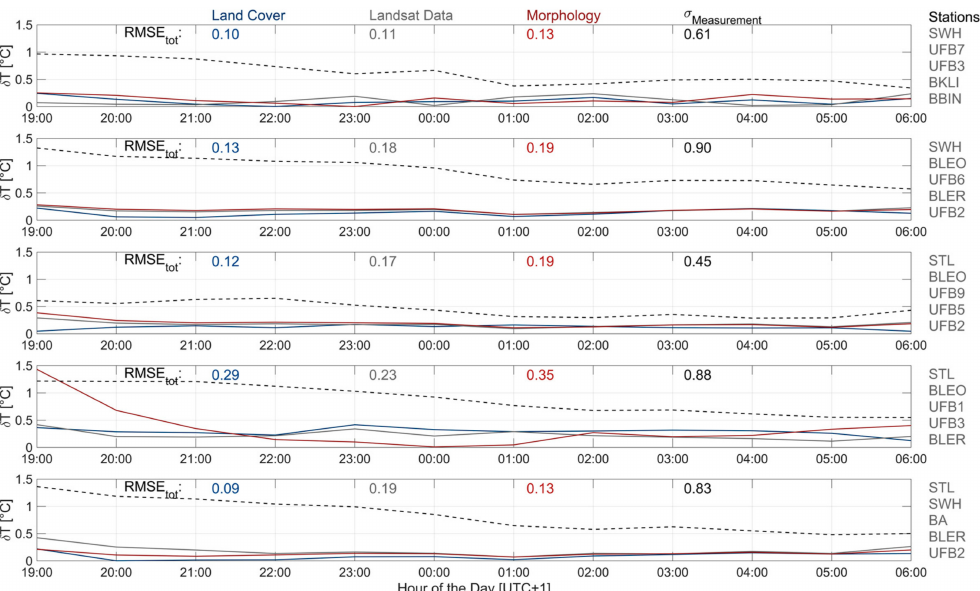
Figure 6. Validation of the model output using five different random samples on a 200 m grid for three groups. For every step in time ( x -axis), the RMSE resulting from the difference between predicted T a to measured T a is indicated for each group. The resulting average is shown as numbers referring to the specific groups according to the color (blue = Land Cover, grey = Landsat Data and red = Morphology) and the stations used for validation are listed at the right side of the plots. The black dotted line depicts the standard deviation of the measured T a used for